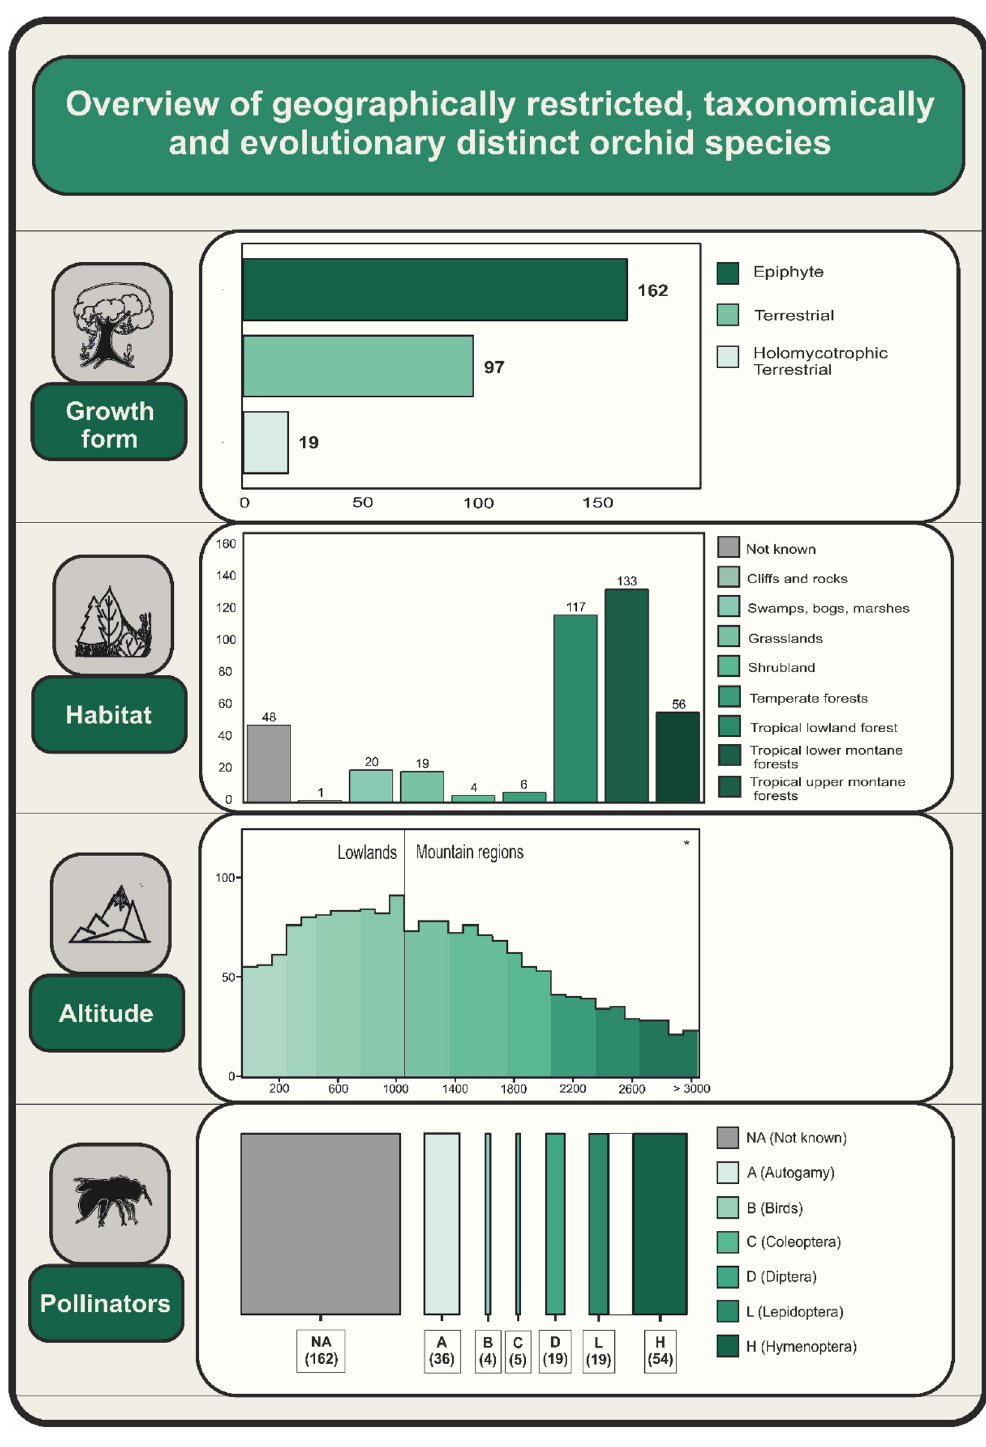
Figure 4. Overview of the 278 priority orchid species, including growth form, habitat, altitude, and pollination